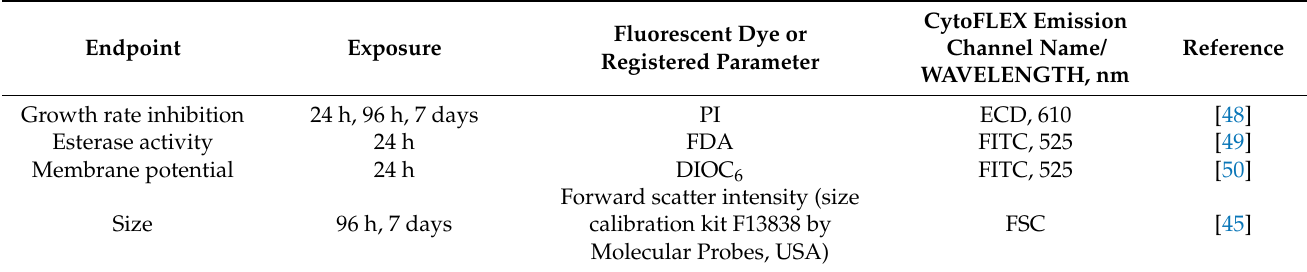
Table 2. The criteria and conditions of the microalgae